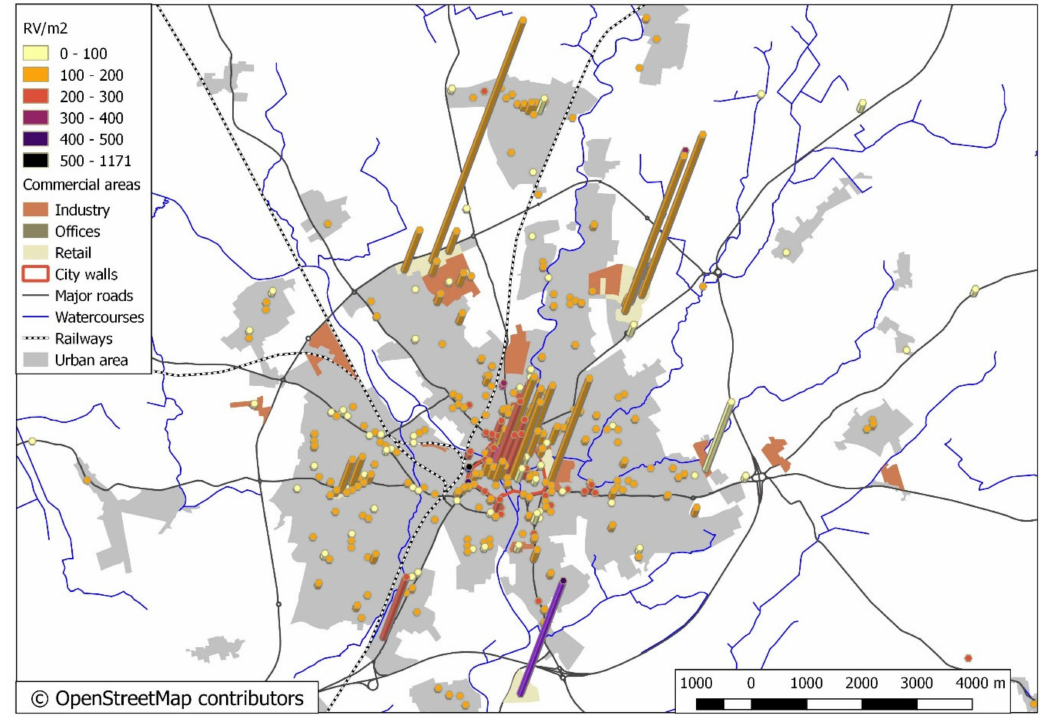
Figure3. RetailRV / m 2 (2019values)aggregatedwithina100mgrid;